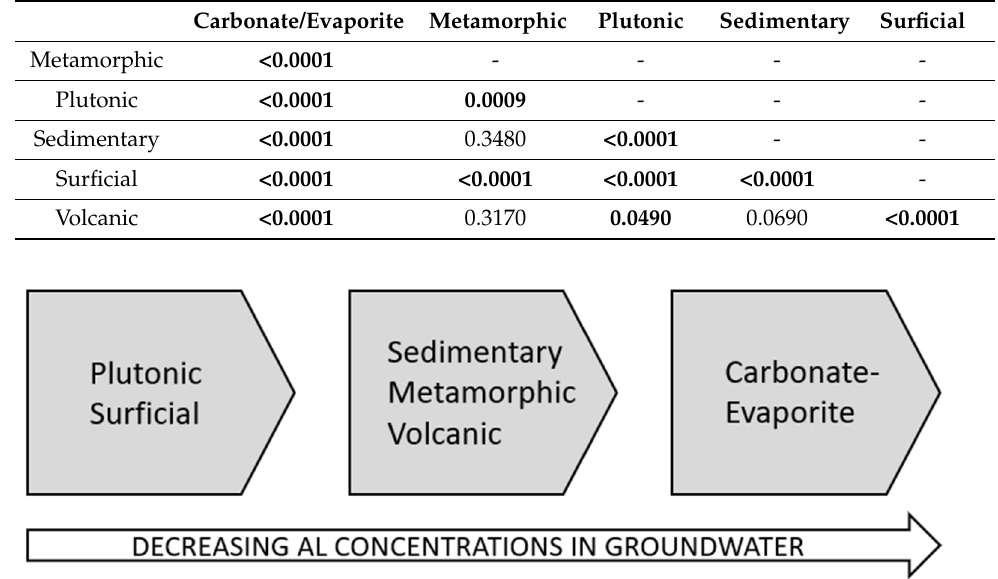
Figure 4. Groupings of groundwater regions with significant differences in associated Al concentra- tions using the Peto and Peto modification of the Gehan–Wilcoxon test.